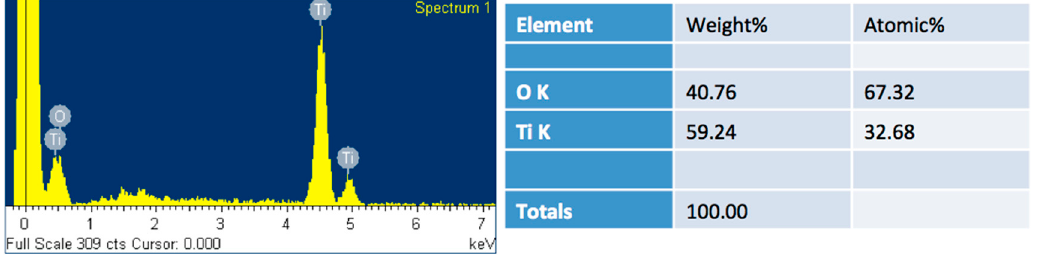
Figure A1. EDS analysis of torched-titanium substrate.